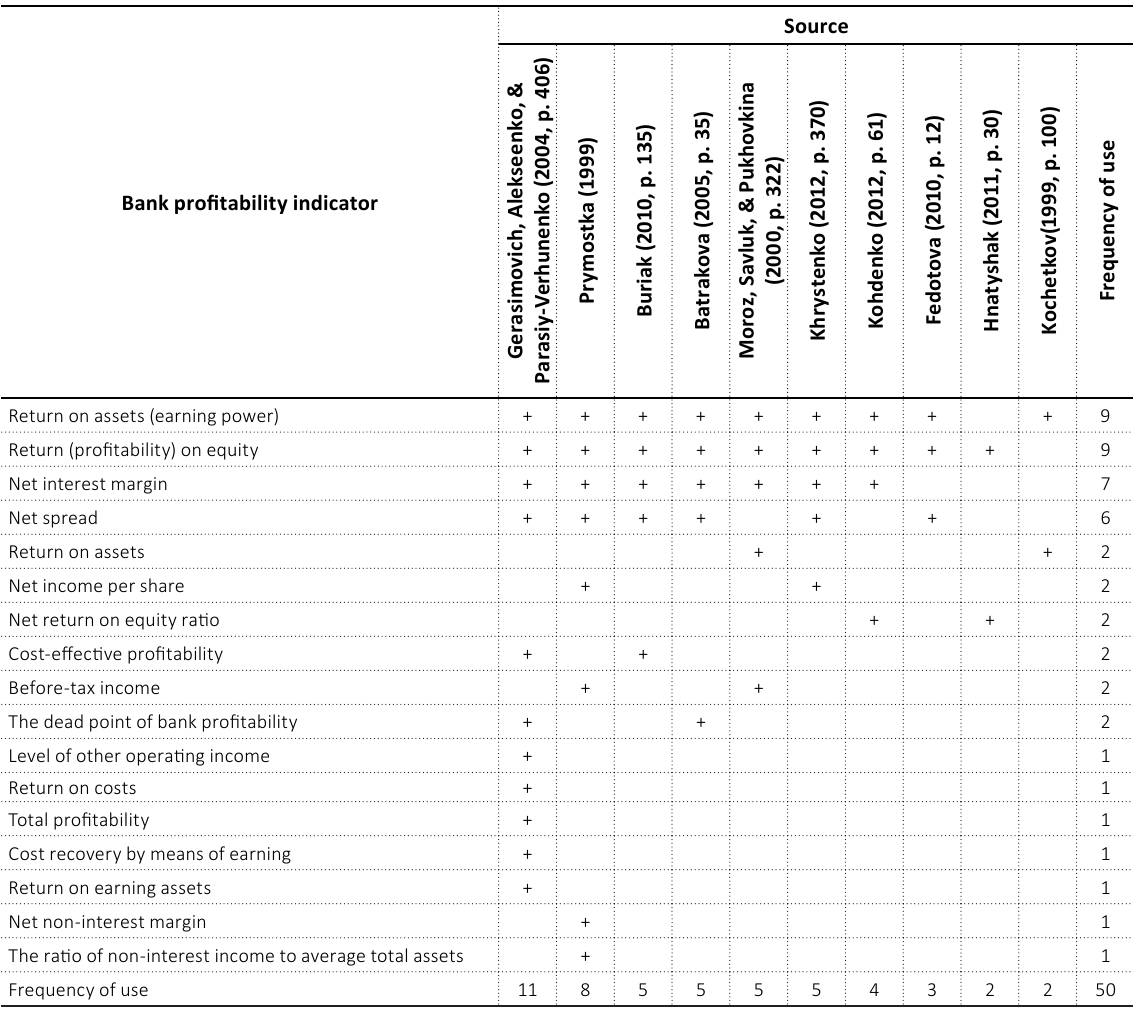
Table 1. Bank profitability ratios